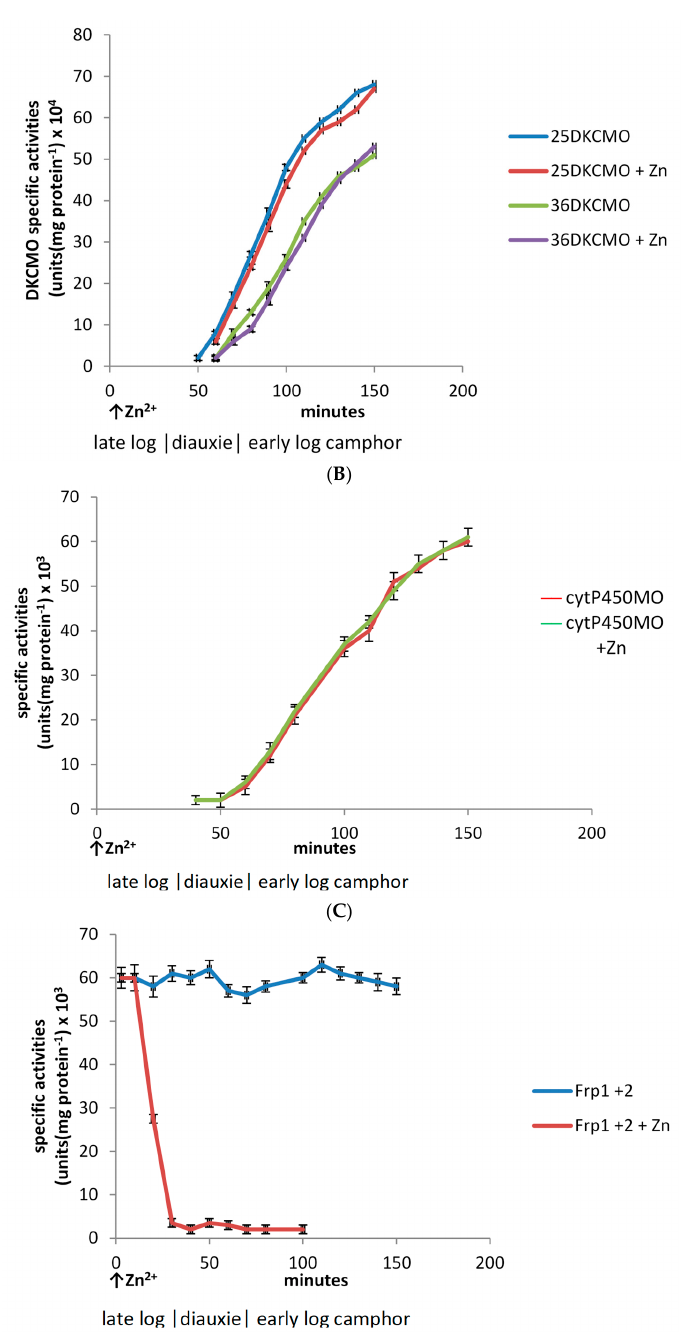
Figure 5. ( A ).Changes in the biomass (A 650 nm) of P.putida ATCC 17453 following addition of 30 µ M Zn 2 + in the diauxic interlude during growth on succinate-( rac )-camphor minimal medium. ( B ) Changes in the activity of the enantiocomplementary DKCMOs of P.putida ATCC 17453 following addition of 30 µ M Zn 2 + in the diauxic interlude during growth on succinate-( rac )-camphor minimal medium. ( C ).Changes in the activity of the cytP450MO of P.putida ATCC 17453 following addition of 30 µ M Zn 2 + in the diauxic interlude during growth on succinate-( rac )-camphor minimal medium. ( D ). Changes in the combined Frp1 + Frp2 activity of P.putida ATCC 17453 following addition of 30 µ M Zn 2 + in the diauxic interlude during growth on succinate-( rac )-camphor minimal medium. In each case, 0–40 min corresponds to late log phase growth on succinate, 41–70 min corresponds to the diauxic interlude, and 71–150 min correspond to early log phase growth on ( rac